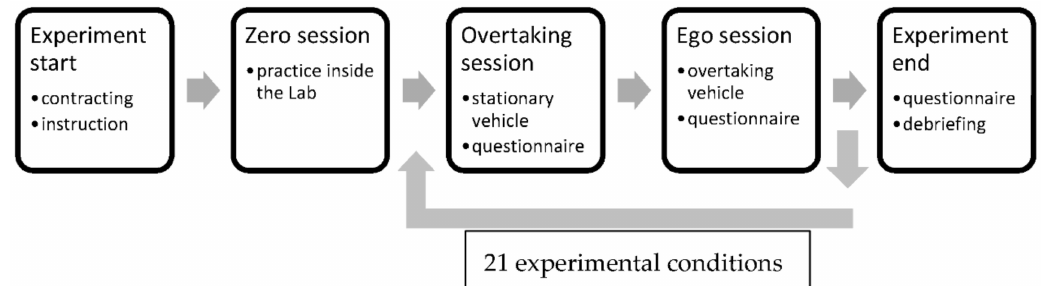
Figure 5. Procedure of the